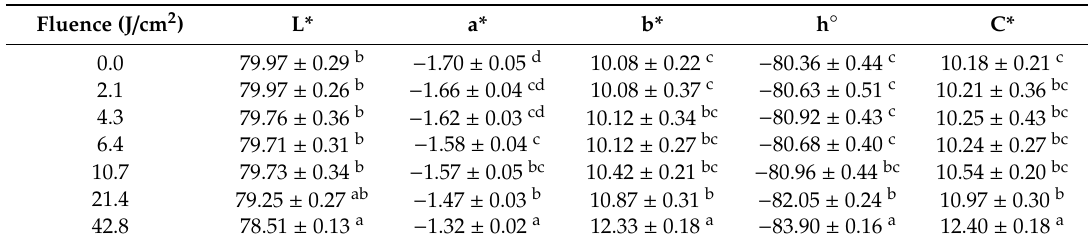
Table 1. E ff ect of pulsed light on the color of white Table 1. Effect of pulsed light on the color of white wine.